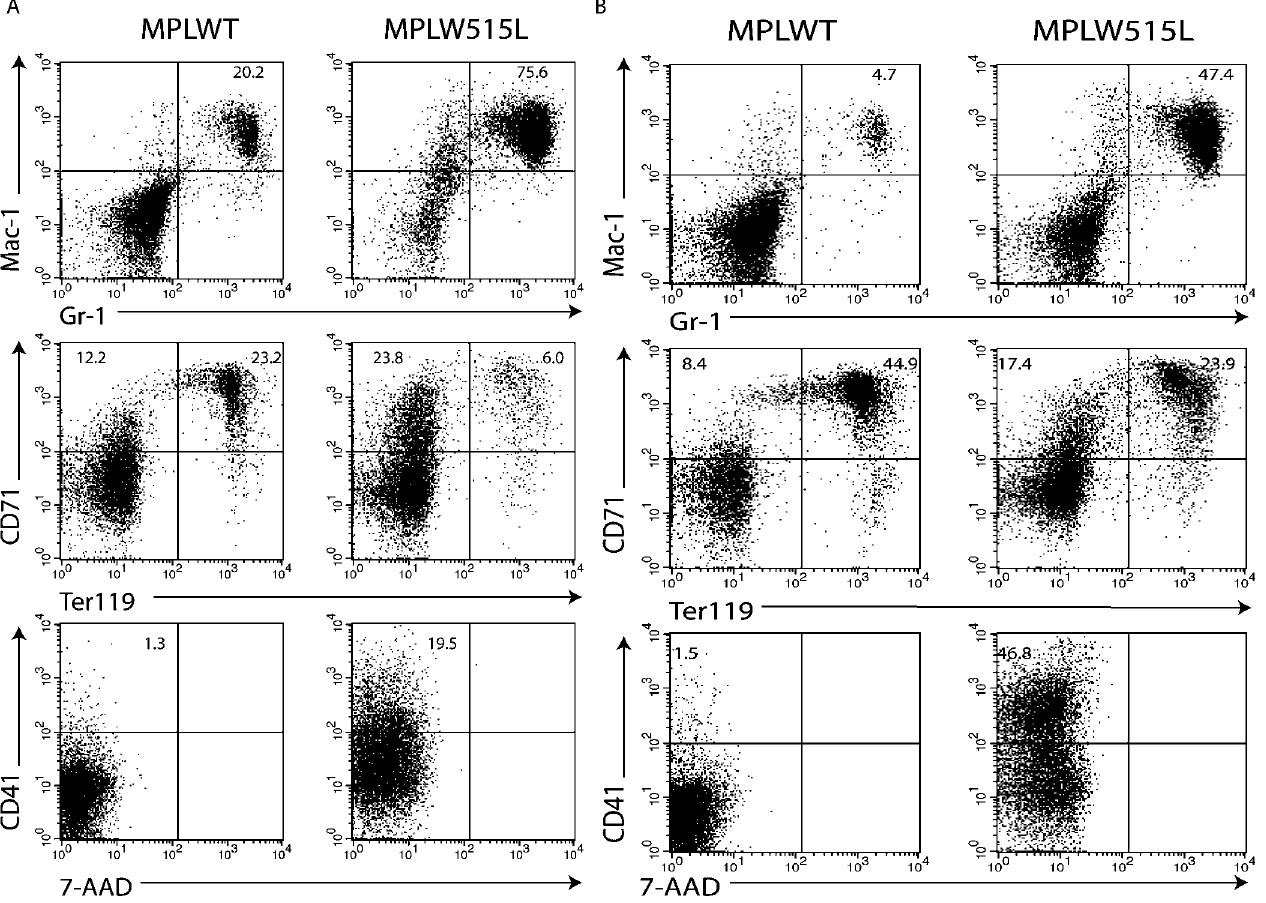
Figure 5. Flow Cytometry Analysis of BM and Spleen in Mice Transduced with MPLW515L and MPLWT (A) Flow-cytometry analysis of bone marrow cells shows a 4-fold increase in Mac1 þ /Gr1 þ cells and a shift to a more immature erythroid population. There is a 15-fold increase in CD41 þ cells in bone marrow expressing MPLW515L compared with MPLWT. (B) Flow-cytometry analysis of spleen cells shows a 10-fold increase in Mac1 þ /Gr1 þ cells in MPLW515L. There is also a shift to a more immature erythroid population in MPLW515L with a greater percentage of CD71 þ /Ter119- cells. CD41 þ cells are increased 30-fold in MPLW515L spleen cells compared with MPLWT spleen cells. DOI: